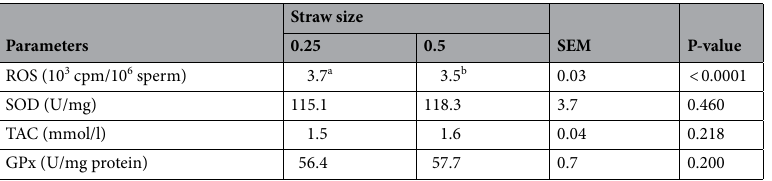
Table 5. Effect of straw size on ROS, glutathione peroxidase (GPx) and superoxide dismutase (SOD) activities and total antioxidant capacity (TAC) of rooster thawed semen. Different superscripts letters within row are significantly different (P <